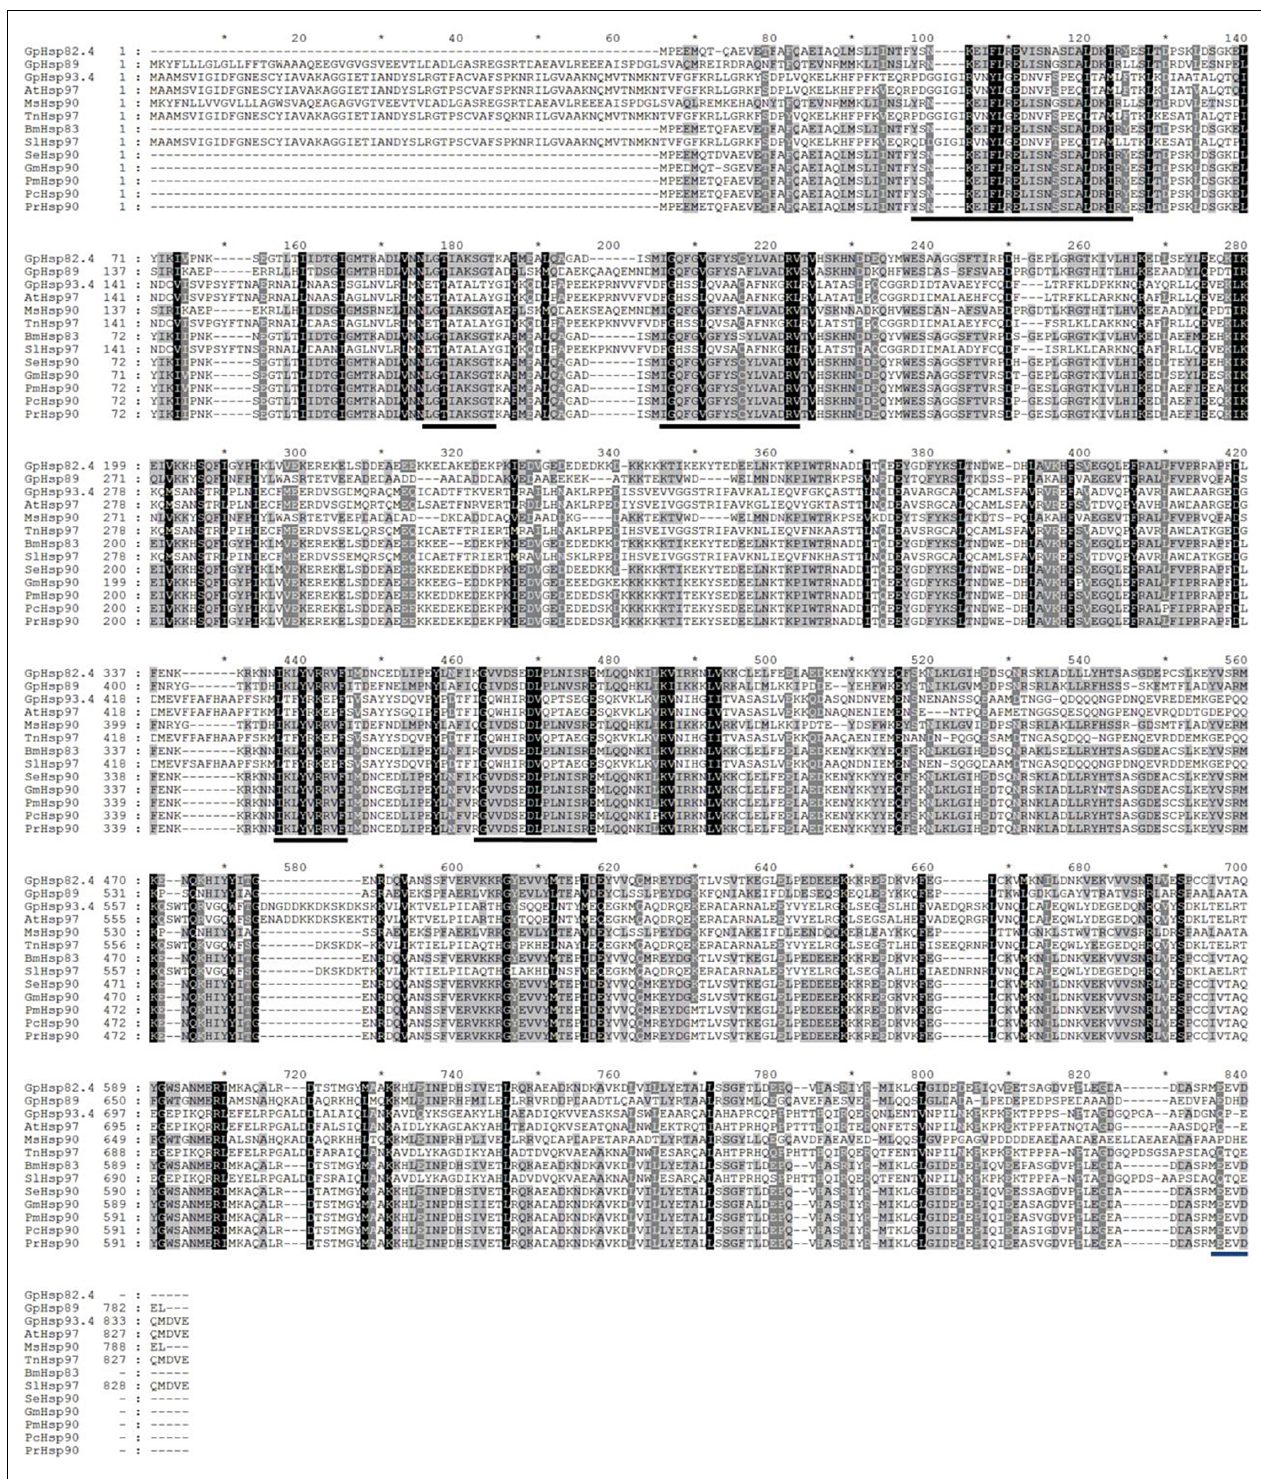
FIGURE 2 | Alignment of the deduced amino acid sequences of Hsp90 genes in G. pyloalis and other Lepidoptera insect. The conserved domains of Hsp90 gene family is underlined in Black solid line. Blue solid line indicates a conserved amino sequence of MEEVD motif at C-terminus. Amyelois transitella (At), Mythimna separata (Ms), Trichoplusia ni (Tn), Bombyx mori (Bm), Spodoptera litura (Sl), Spodoptera exigua (Se), Grapholita molesta (Gm), Pieris melete (Pm), Pieris canidia (Pc), Pieris rapae (Pr).